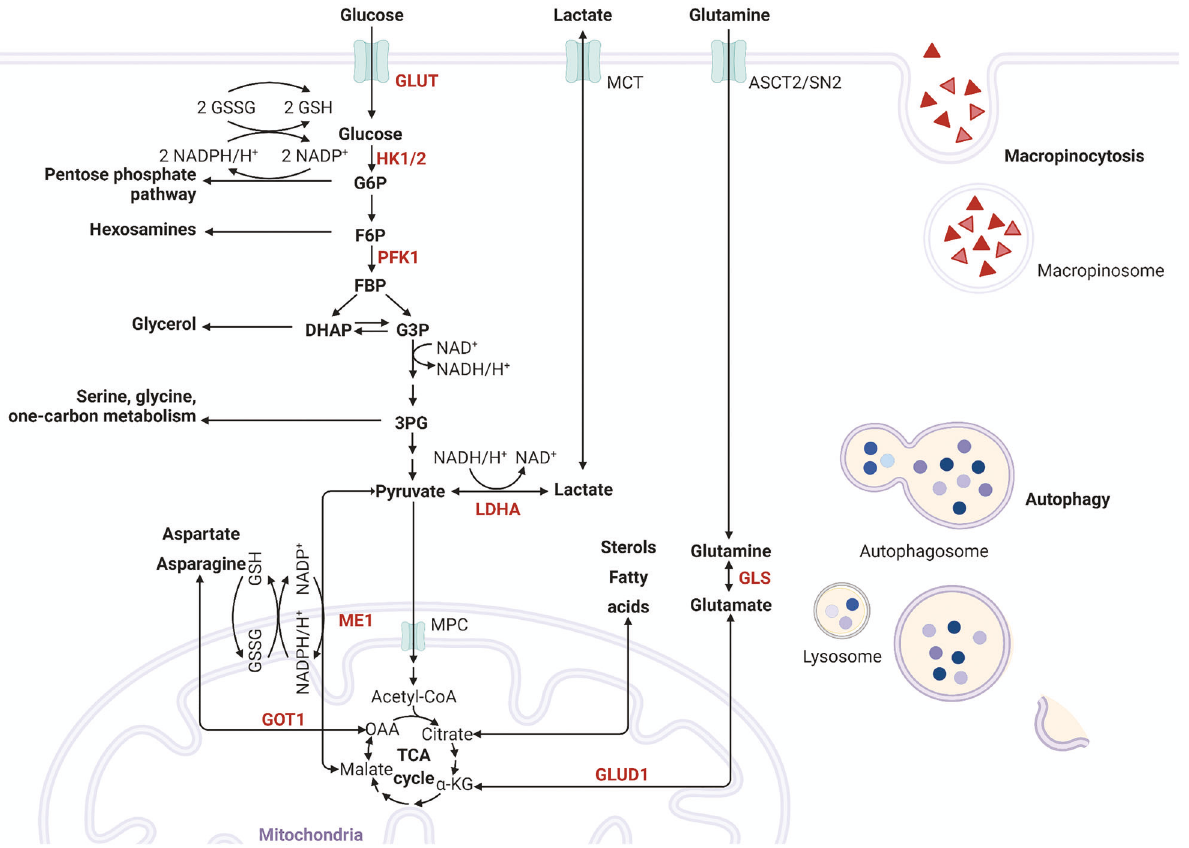
Fig. 1 Mutant KRAS mediated metabolic alterations. The active oncogenic KRAS mutant triggers glycolysis for energy generation and building block biosynthesis and shunting into the nonoxidative arm of the pentose phosphate pathway for nucleic acid biosynthesis and the hexosamine biosynthesis pathway for UDP-N-acetylglucosamine biosynthesis through upregulation of key enzymes in glycolysis. In addition, micropinocytosis and autophagy ensure that mutant KRAS cancer cells obtain energy and biosynthetic building blocks from the microenvironment. GLUT1 glucose transporter 1, HK1/2 hexokinases 1 and 2, PFK1 phosphofructokinase 1, LDHA lactate dehydrogenase A, ASCT2, also known as solute carrier family 1, member 5 (SLC1A5); SN2, also known as solute carrier family 38, member 5 (SLC38A5); MCT monocarboxylic transporters, GOT aspartate transaminase, GLUD1 glutamate dehydrogenase 1, GLS1 glutaminase 1, G6P glucose 6- phosphate, F6P fructose 6-phosphate, FBP fructose 1,6-phosphate, DHAP dihydroxyacetone phosphate, G3P glyceraldehyde 3-phosphate, 3PG 3-phosphoglycerate, α KG α -ketoglutarate, Asp aspartate, OAA oxaloacetate, TCA cycle tricarboxylic acid cycle. The graph was created with